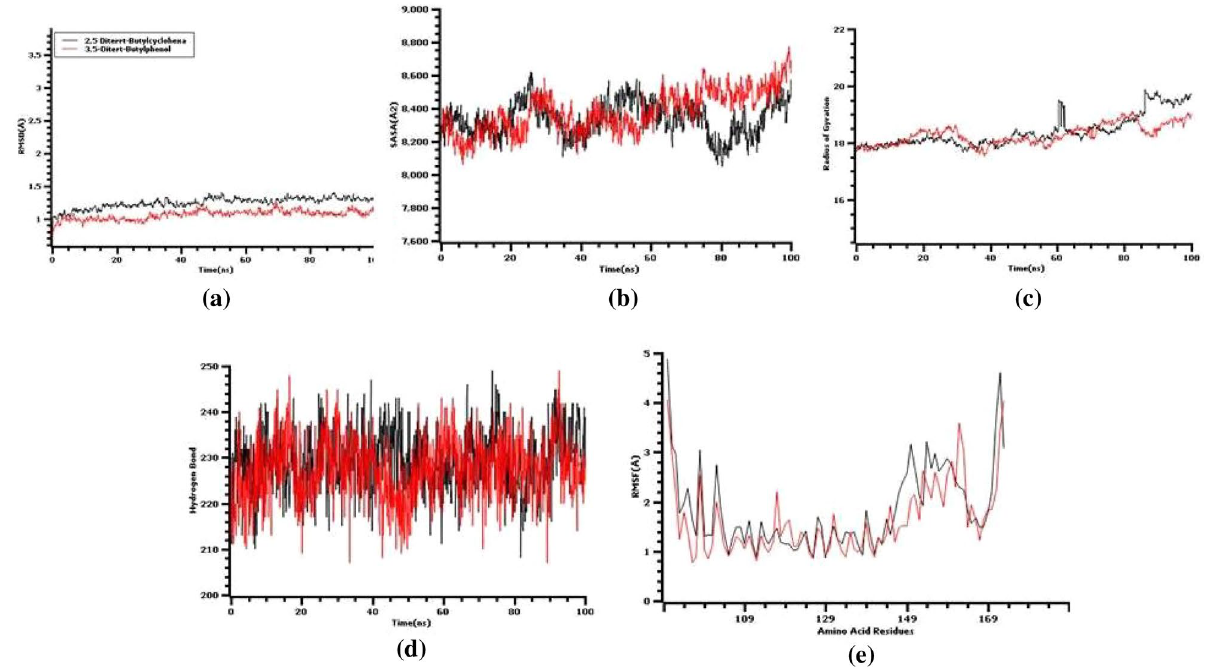
Figure 13. The molecular dynamics simulation. ( a ) Root mean square deviation of the two docked complexes, ( b ) solvent accessible surface area, ( c ) radius of gyration, ( d ) hydrogen bond of the docked complexes, and ( e ) root mean square